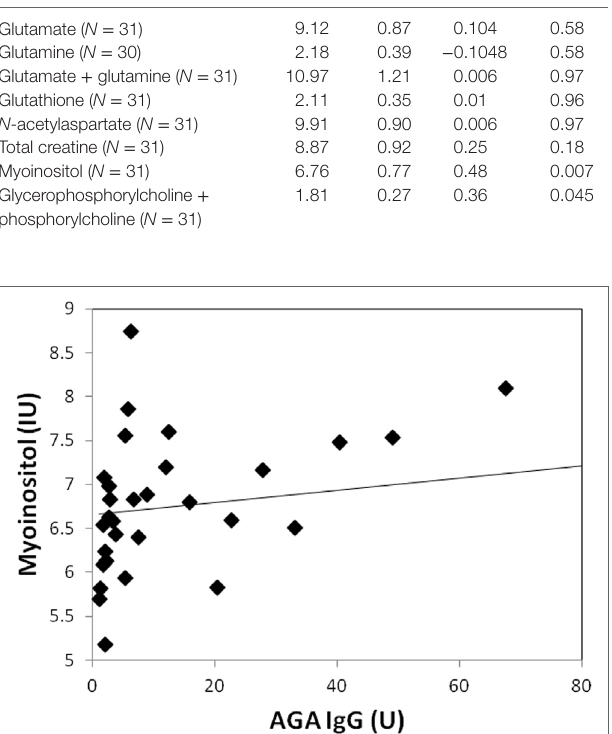
FigUre 2 | Correlation plot showing a strong positive relationship ( r = 0.48, p = 0.007) between AGA IgG and myoinositol levels. 31/33 of the participants had data available.